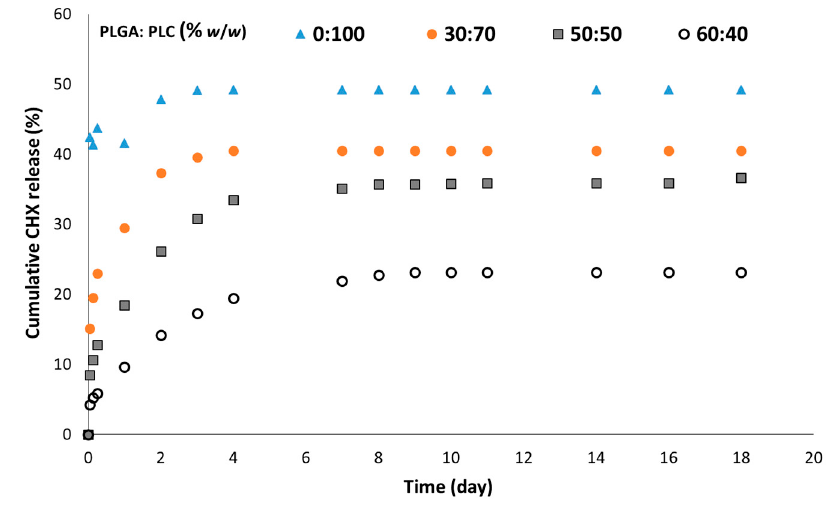
Figure 6. Cumulative CHX release according to the PLGA / PLC ratio. CHX-CD loading was 4%, measured by UV spectrometry.